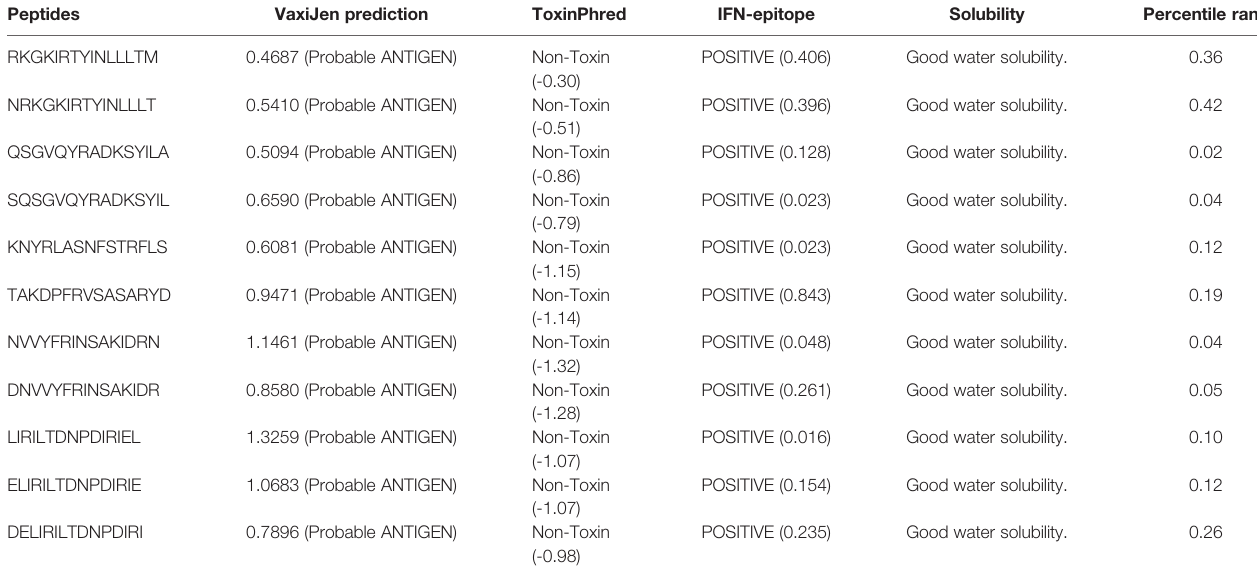
TABLE 3 | Selected potent MHC-II epitope candidates.